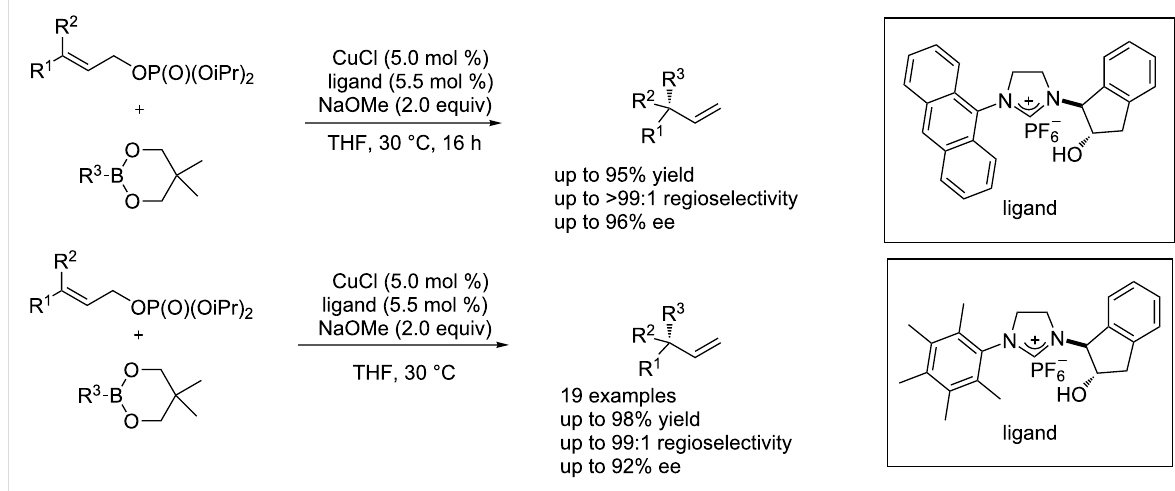
Scheme 25: Copper-catalyzed asymmetric allylic substitution of allyl phosphates.